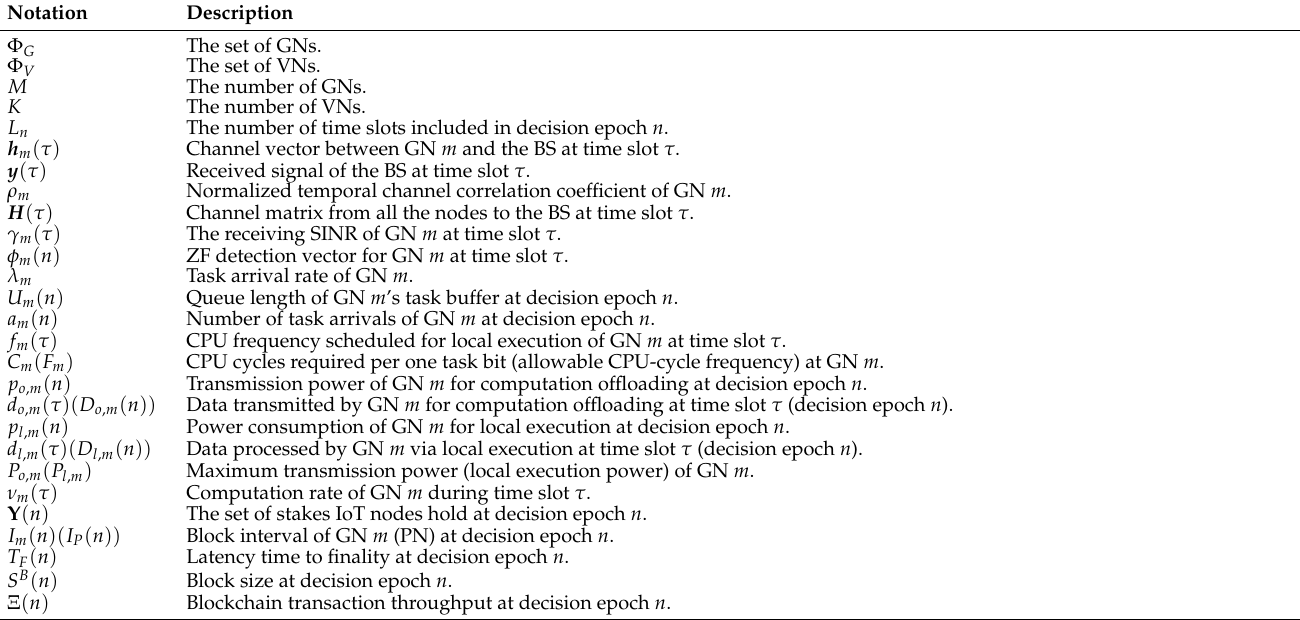
Figure 2. MEC-enabled blockchain system in the heterogeneous IoT networks. Table 2. Notation